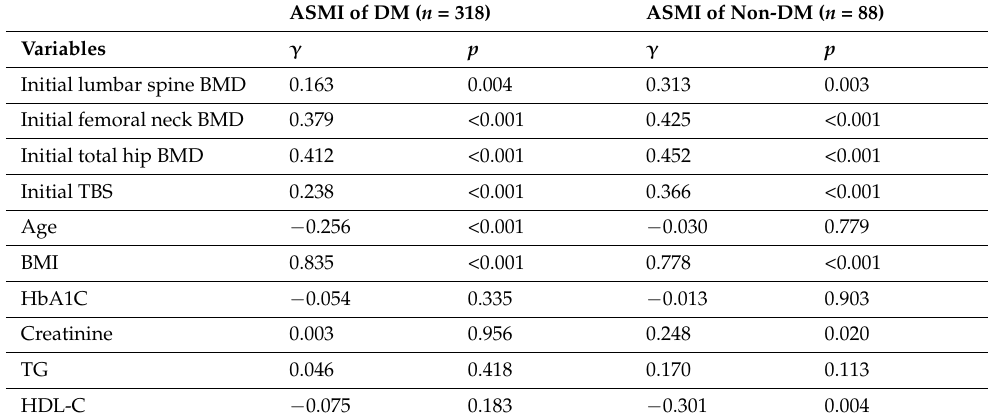
Table 2. Simple correlation of ASMI with bone-related parameters and metabolic